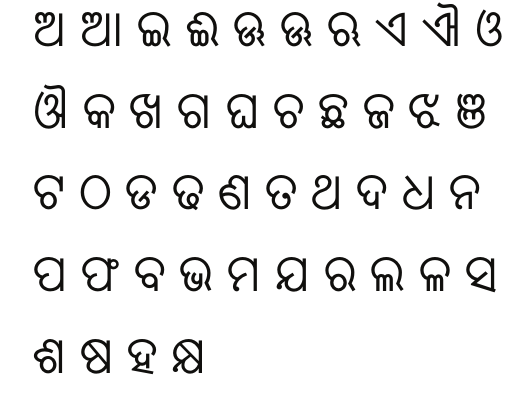
Figure 1. Odia characters